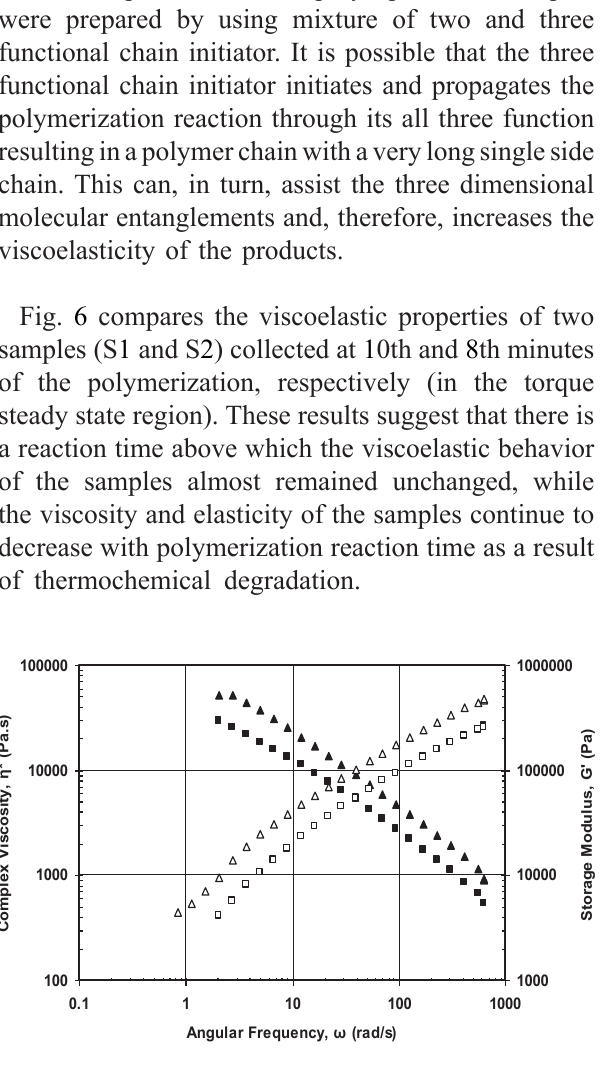
Fig. 6 . Complex viscosity (η*) and storage modulus (G’) vs. angular frequency (ω) for two samples S 1 ( ,Δ) and S 2 ( ,  ).